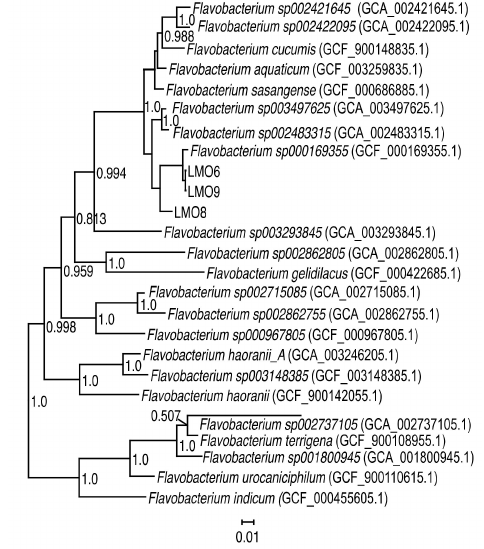
Figure 1. Phylogenomic placement of the three strains from this study—LMO6, LMO8, and LMO9—in the GTDB phylogeny [71]. The three strains were placed with GTDBtk [70] and here visualised together with their closest Flavobacterium spp. relatives. Numbers at nodes are bootstrap values (values below 0.5 are not